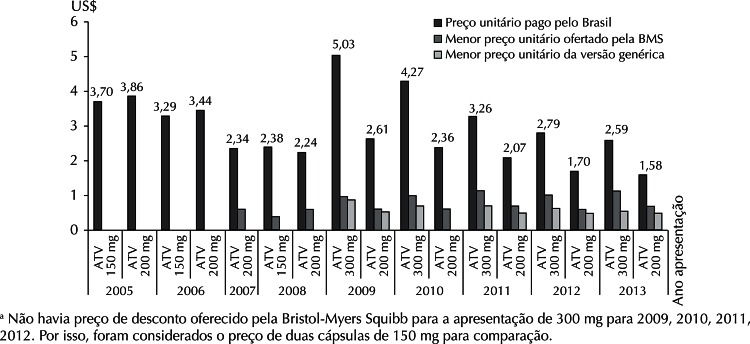
Comparação do preço pago pelo Ministério da Saúde para o atazanavir 150 mg, 200 mg e 300 mga com os preços de desconto ofertado pela Bristol-Myers Squibb e os preços da versão genérica. Brasil, 2005 a 2013.